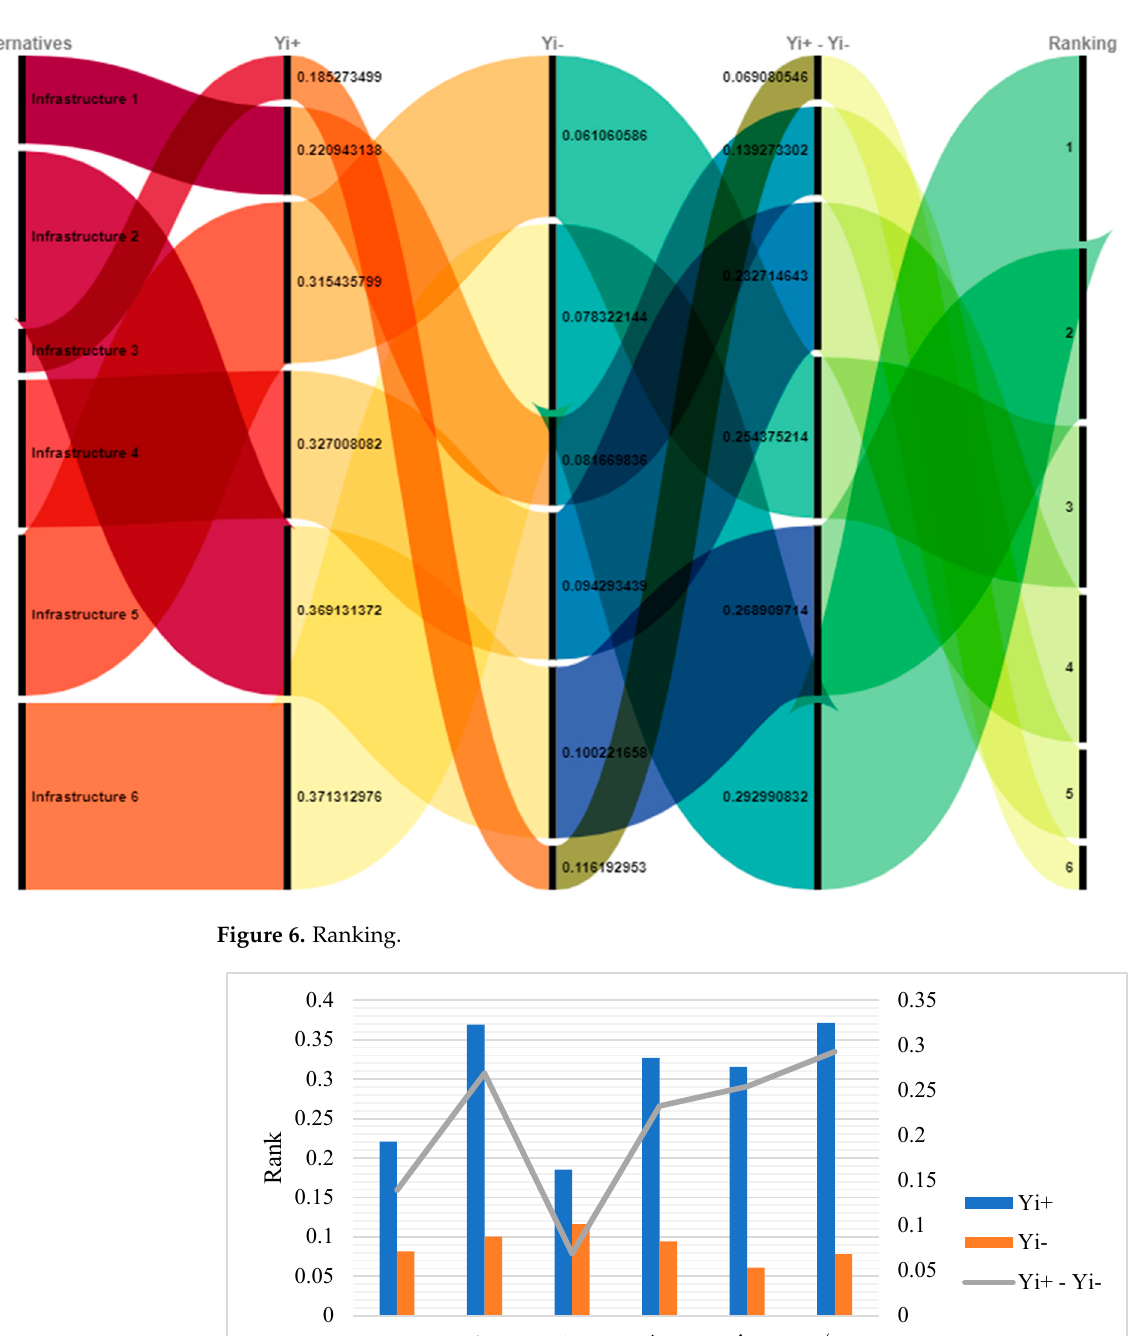
Figure 7. Relationship among alternatives.